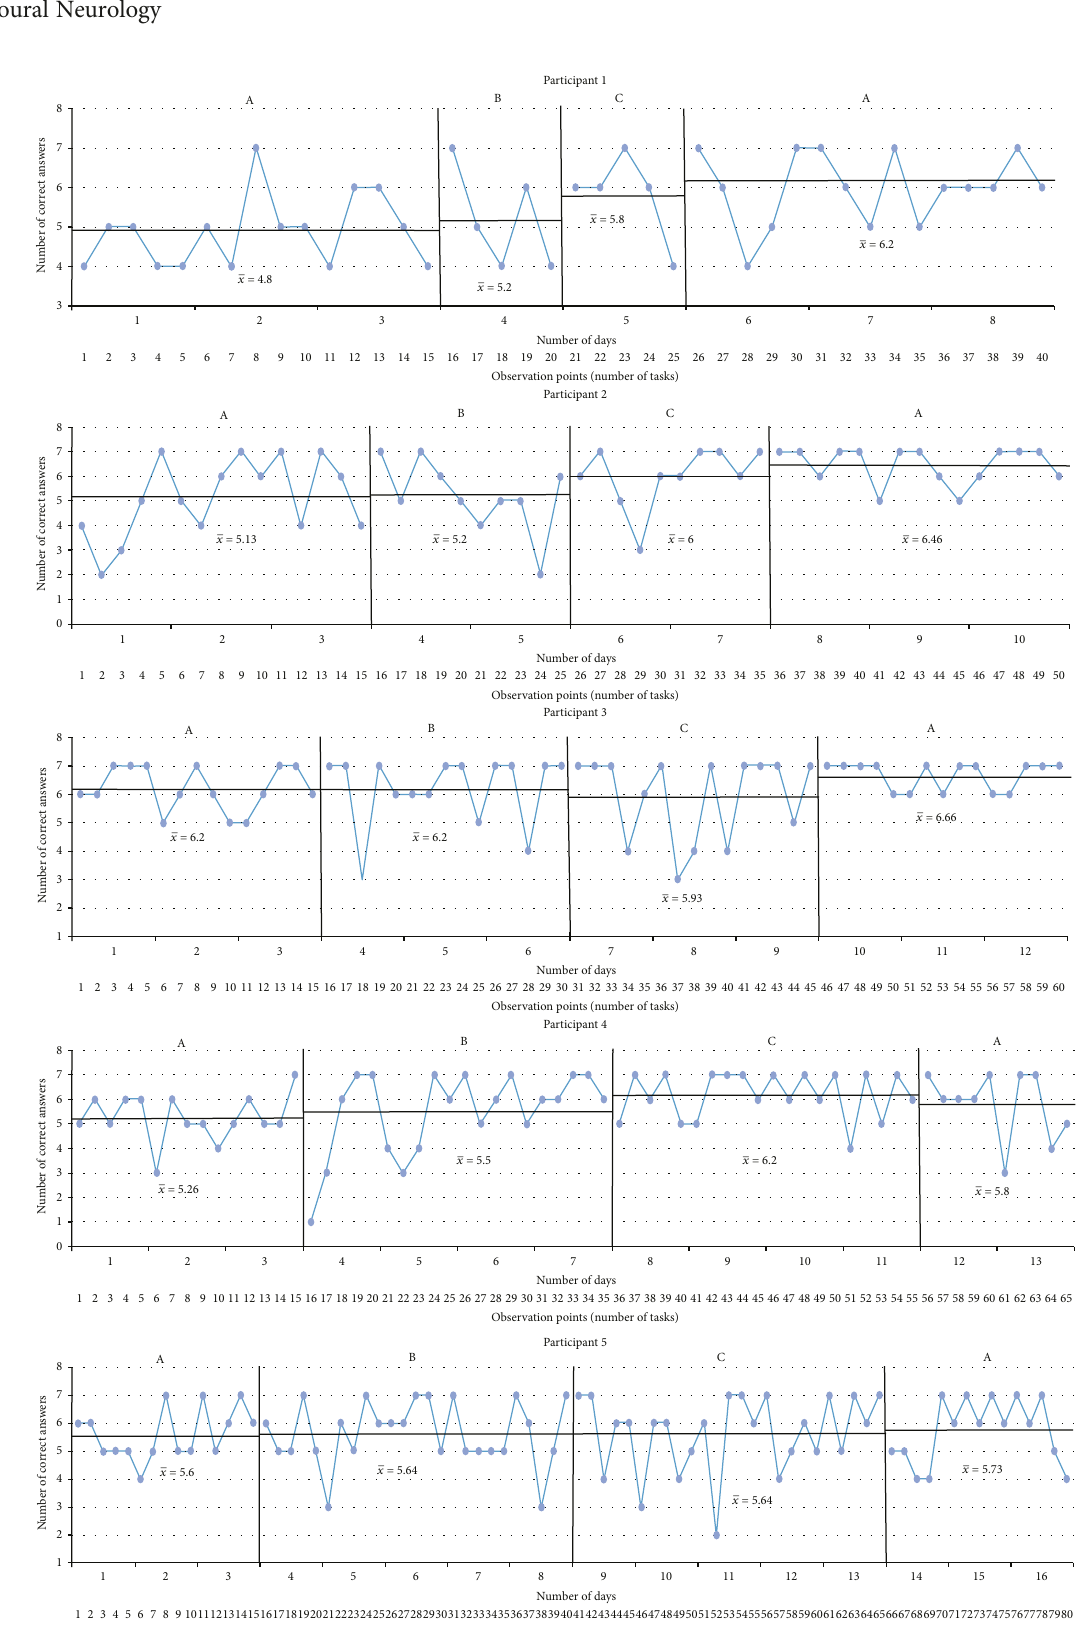
Figure 4: Illuminated windows. A: baseline; B: sham tDCS; C: tDCS; x -axis: observation points in number of tasks performed within days; y -axis: number of correct answers. Scores are shown, along with black lines marking the average of each